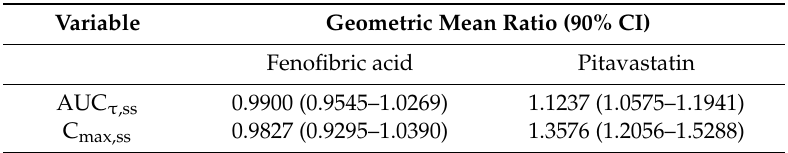
Abbreviations: AUC τ ,ss : area under the plasma concentration-time curve over the dosing interval at steady state; C max,ss : maximum plasma concentration at steady state.